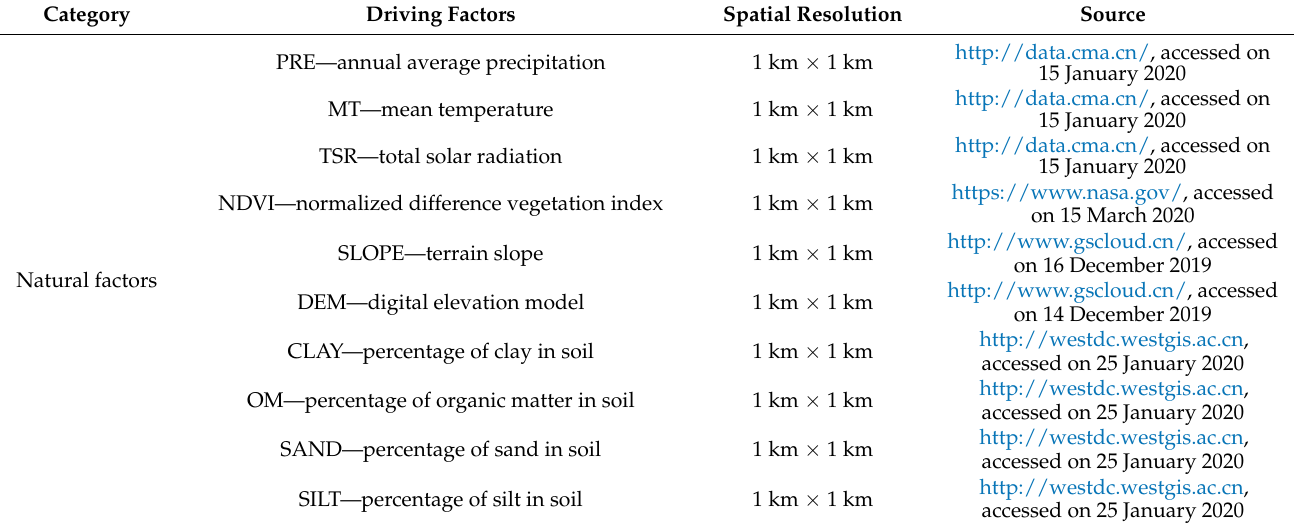
Table 3. Driving factors selected for this